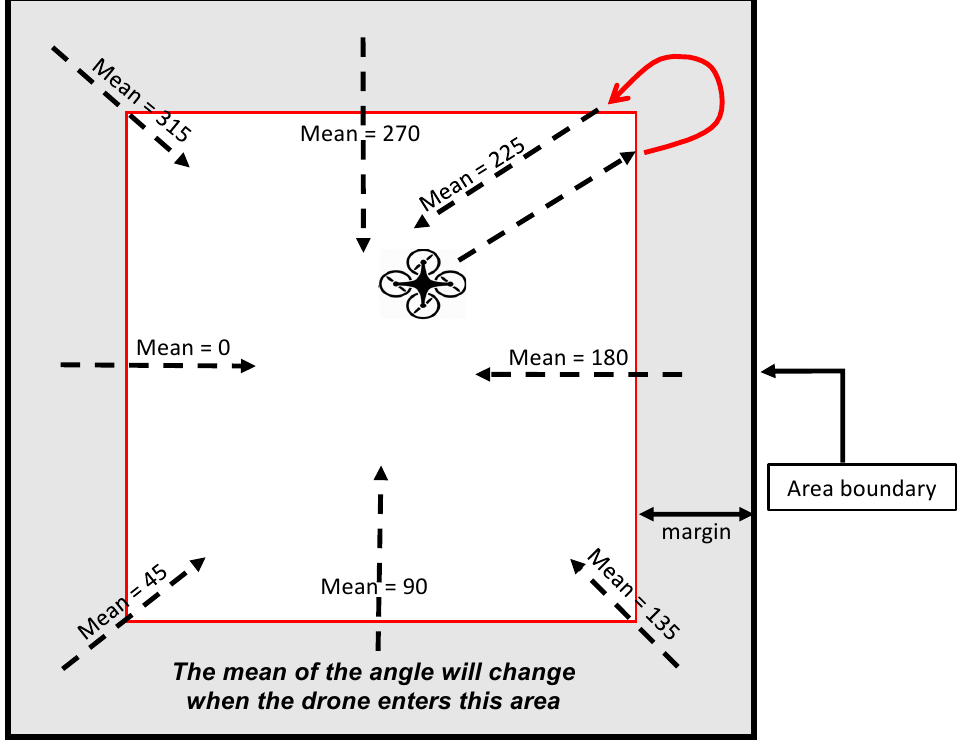
Figure 2. Change of mean angle near the